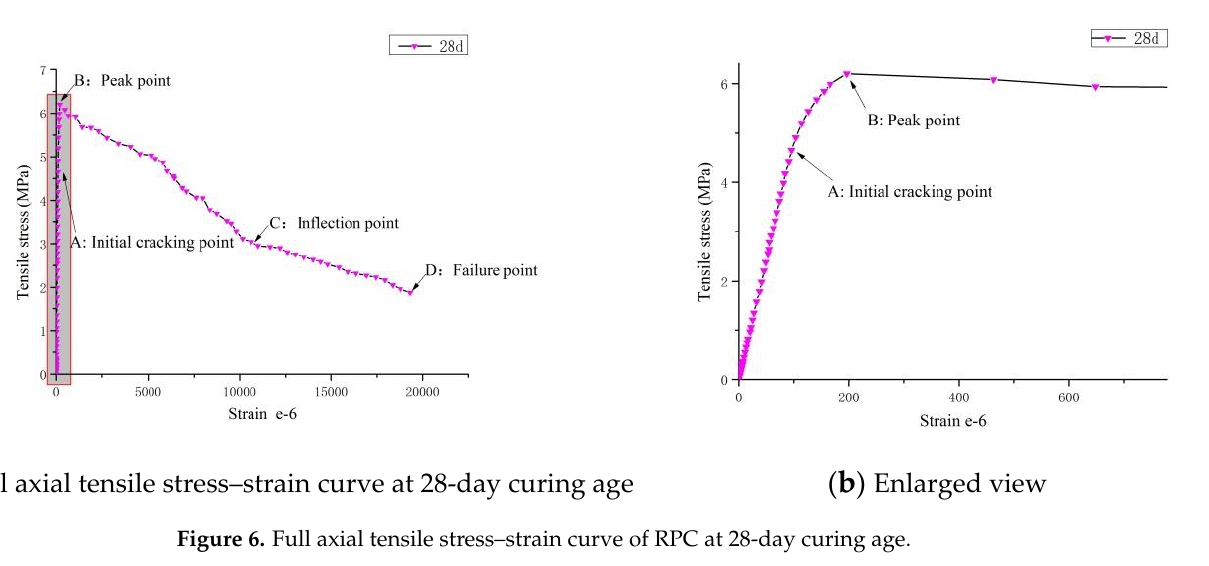
Figure 7. Axial tension strains, tangent elastic modulus curve of RPC. The main results of the RPC axial tensile test are listed in Table 3. According to the data in the table, with an increase in curing age, the compressive strength and tensile strength of RPC increase significantly. The difference is that the compressive strength in- creases obviously with increasing curing age, while the tensile strength at 3 days reaches 83% of that at 28 days, and slowly increases at a later stage. The elastic modulus also in- creases with increasing curing age, about 81% of the elastic modulus at 28 d develops after 3 d, and slowly increases at a later stage. As compared with compressive strength, it is obvious that both tensile strength and the elastic modulus develop significantly at an early age. The initial tensile strain and the ultimate tensile strain both increase with curing age. Next, we discuss the relationship between the initial and ultimate tensile strains.